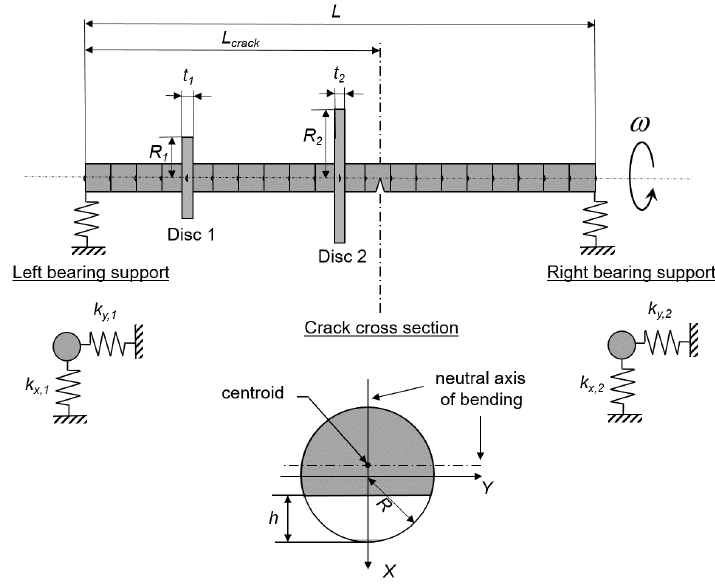
Figure 1. Model of a rotor system with one